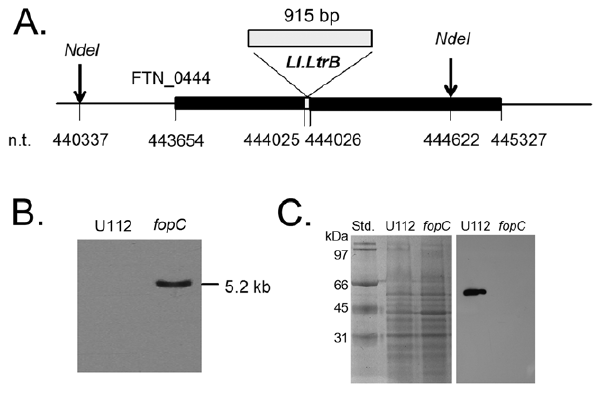
Figure 1. Generation of the fopC -null mutant (KKF332) of F. novicida U112. (A) Schematic representation of Ll.LtrB intron insertion in the fopC locus (FTN_0444) of KKF332. (B) Total genomic DNA, from wildtype U112 and insertion fopC mutant strain (FTN_0444:: Ll.LtrB) cells, was digested with NdeI and blots were probed using an intron- specific probe. The number to the right of the panel indicates the molecular mass in kilobases based on DNA standards. (C) U112 and fopC strain cell lysates were separated by 10% SDS-PAGE, transferred onto a PVDF membrane, and probed with polyclonal FopC antisera.